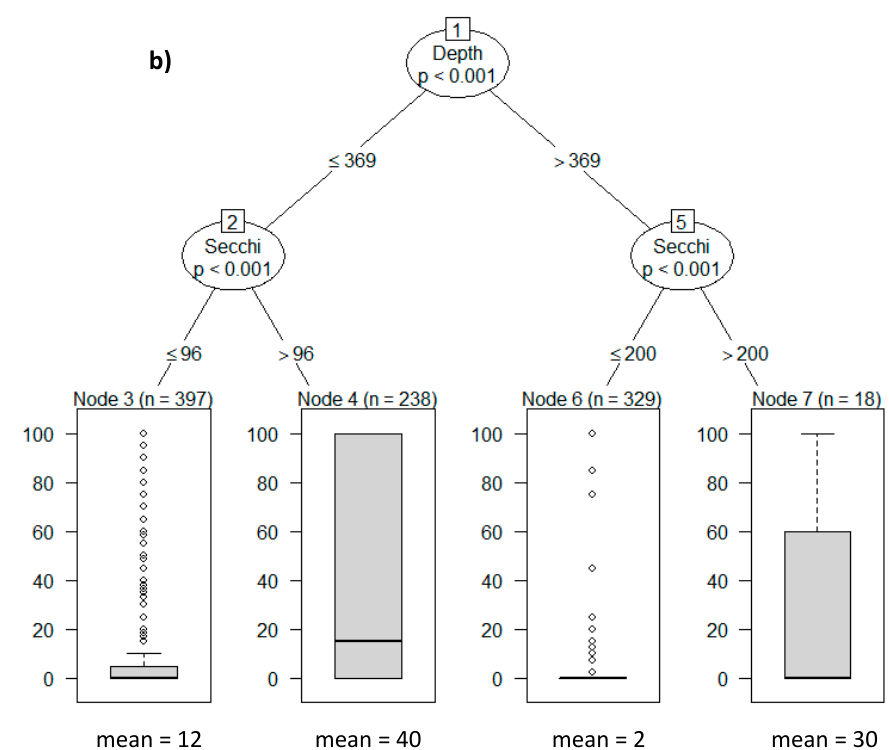
Figure 7. Conditional Inference Trees for ( a ) Lake Mogan and ( b ) Lake Eymir (Depth: water depth, Secchi : Secchi depth, n: number of sampling points, mean: mean macrophyte coverage). The data in the figure represent plant coverage and Secchi depth values measured at each transect point during the plant surveys each year.